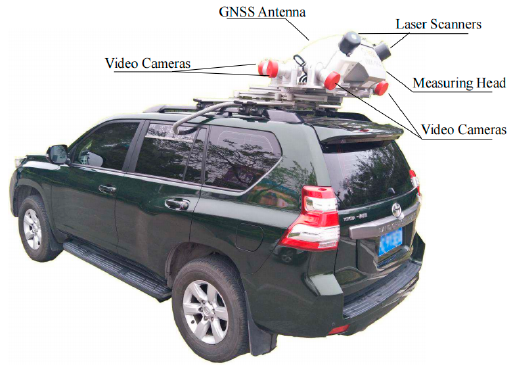
Figure 2. A floating vehicle used for NDD collection [54].